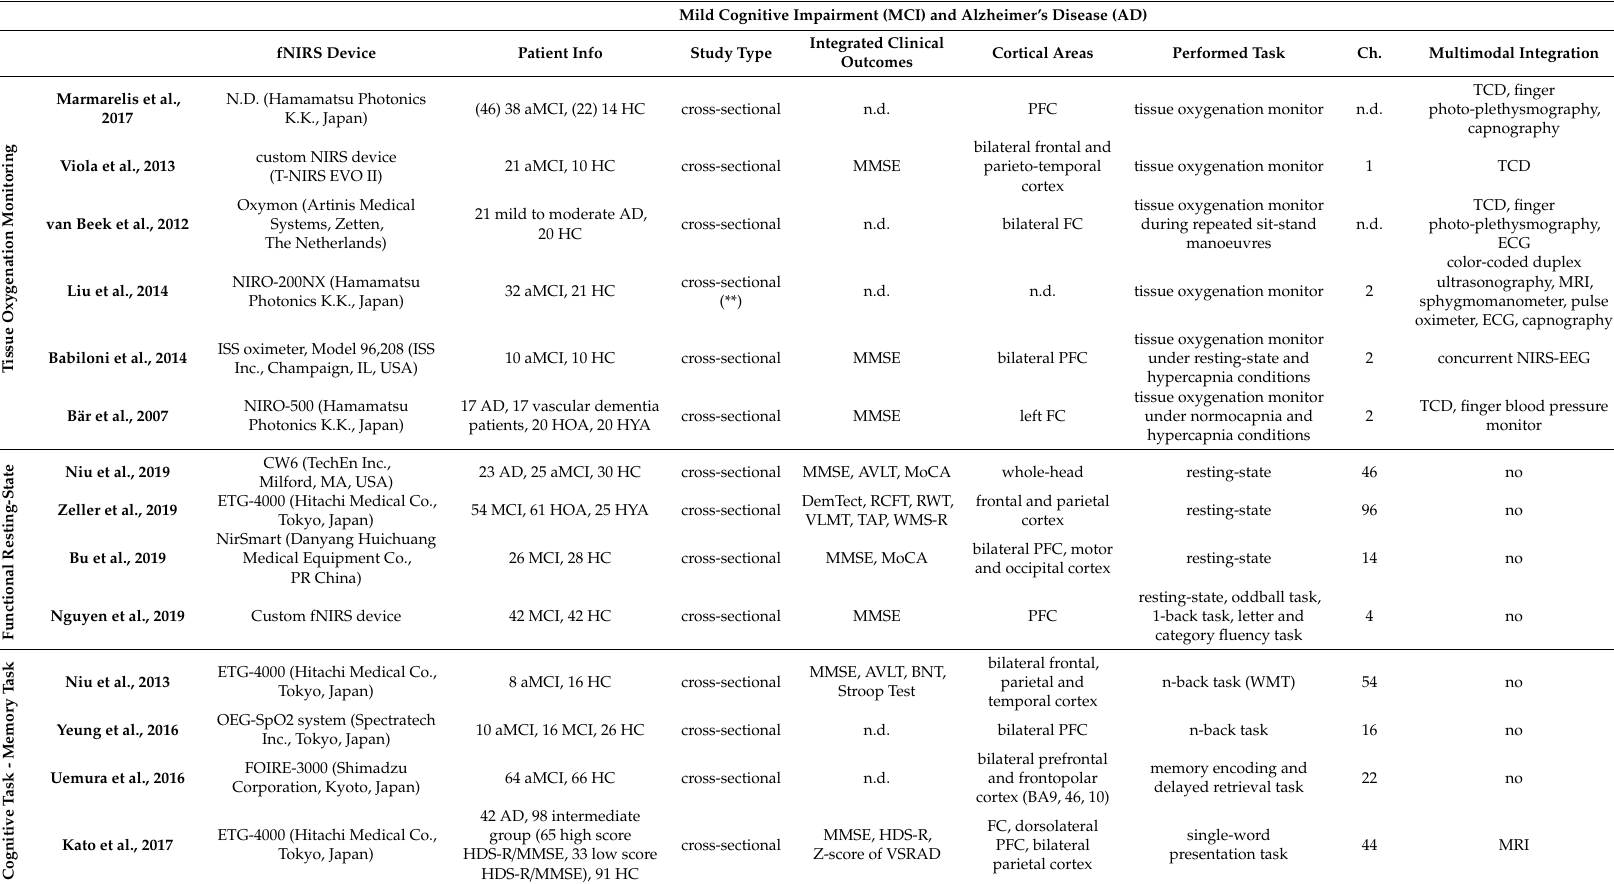
Table 2. Summary of peer-reviewed articles of fNIRS applications in AD and Mild Cognitive Impairment (MCI) patients found trough literature search of NCBI PubMed and Web of Science